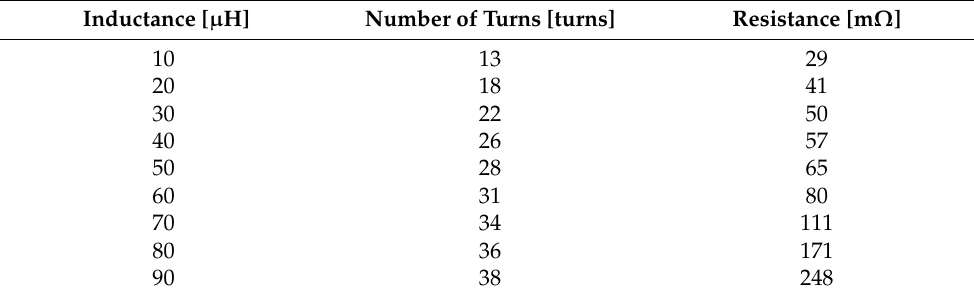
Table A4. Results for the toroidal inductors as analyzed by EM solver 1 .